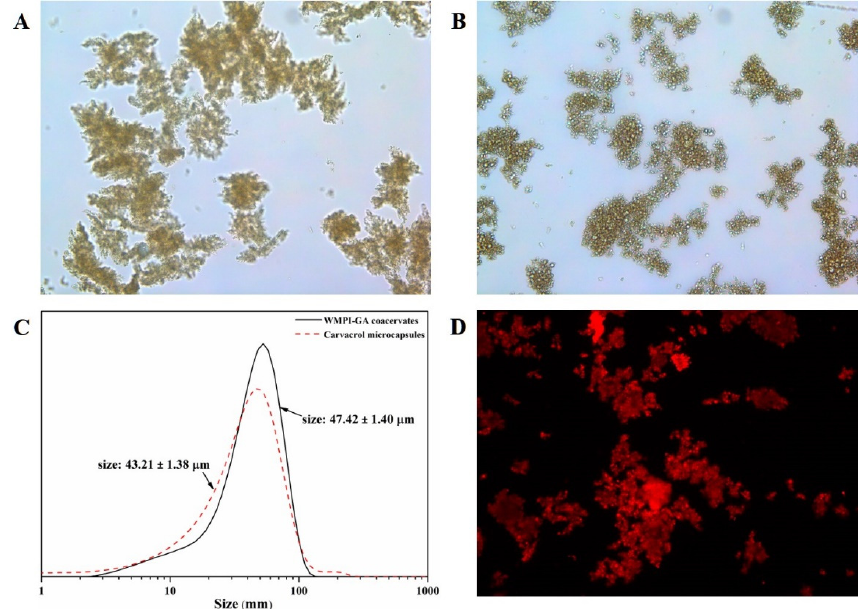
Figure 4. Upright fluorescence microscopic images of WMPI-GA coacervates and carvacrol micro- capsules at the magnification of ×200. WMPI-GA coacervates and carvacrol microcapsules under bright field ( A,B ); Size distribution ( C ); The stained carvacrol microcapsules under fluorescence field ( D